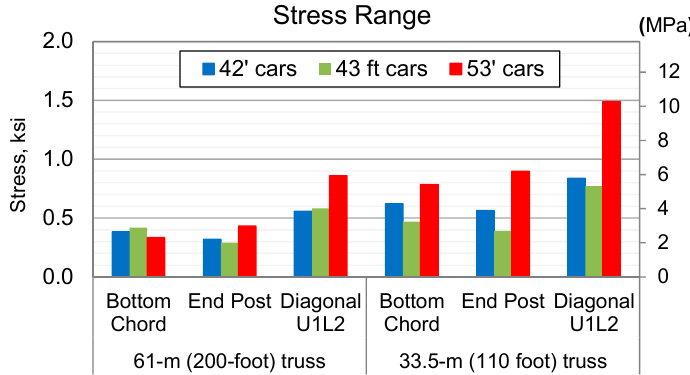
Figure 13. Stress range calculated from measured strains, comparisons for 33.5 ‐ m (110 ‐ ft) and 61 ‐ m (200 ‐ foot) spans.